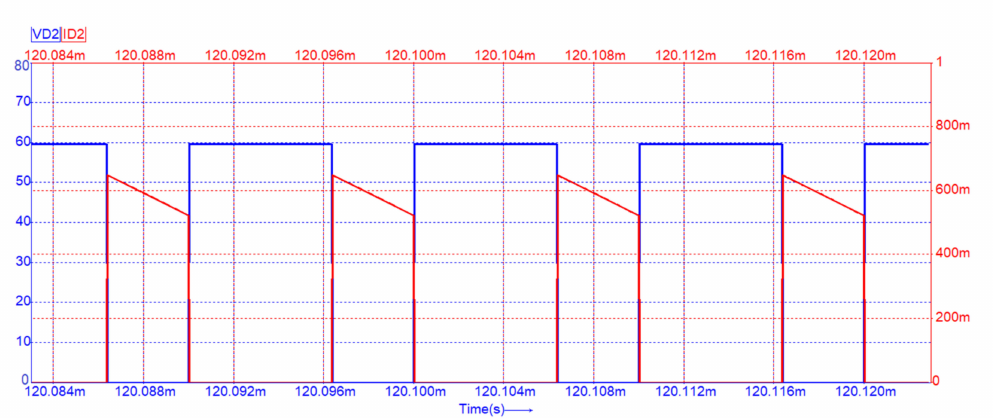
Figure 17. Voltage and current corresponding to the diode D 2 .